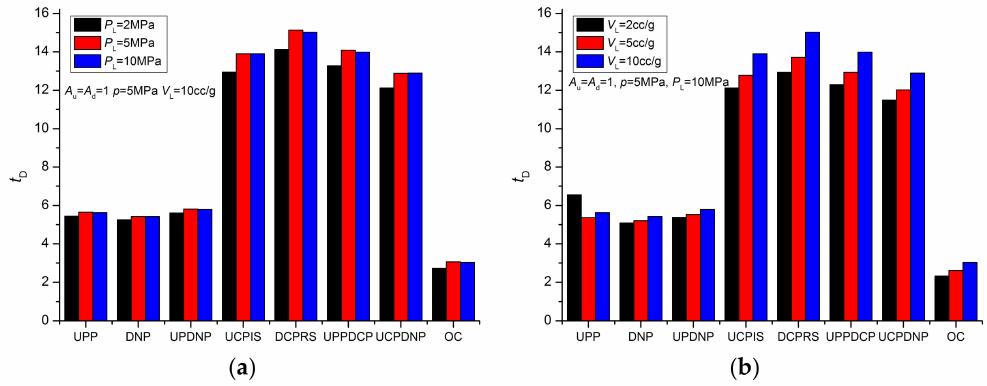
Figure13. Effectofgasadsorptiononpressureequilibriumtime: ( a )Langmuirpressure;( b